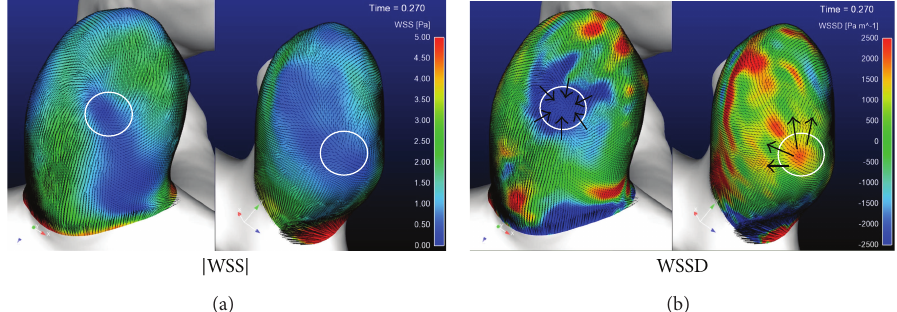
Figure 2: | WSS | and WSSD distributions at the systolic for a ruptured aneurysm.